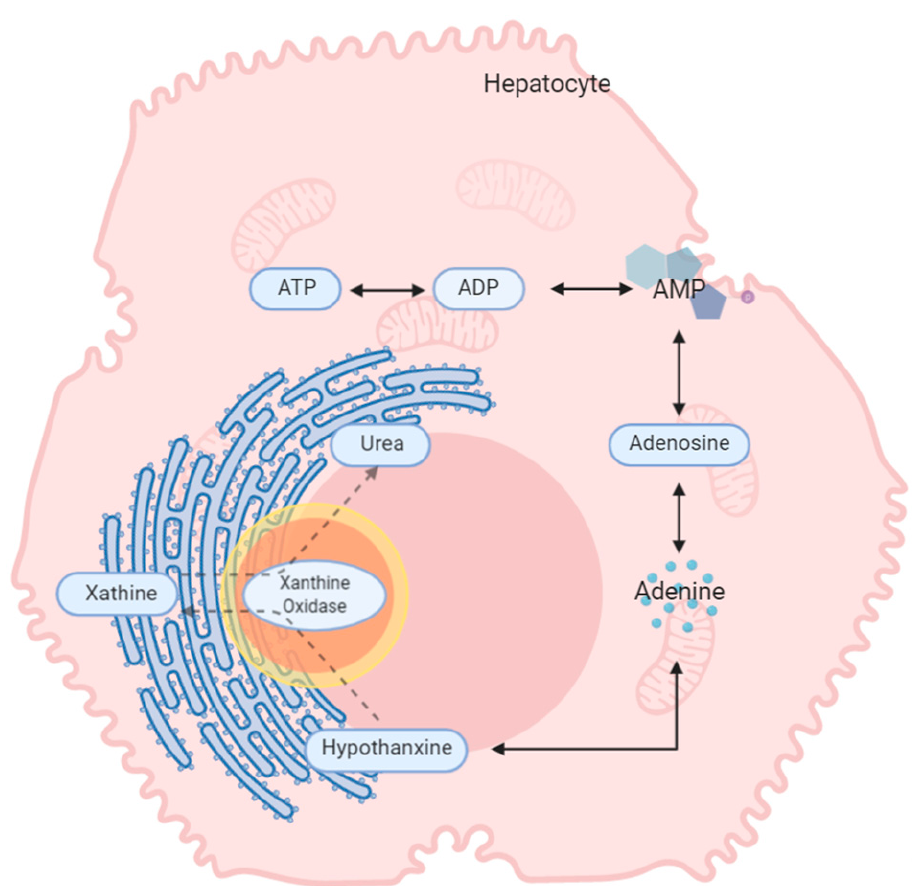
Figure 4. The proposed metabolic changes taking place in explanted liver. During energy production, phosphate groups are sequentially hydrolysed from ATP, creating ADP and then AMP. From AMP, the other metabolites are generated via a number of catabolic pathways. ATP, adenosine triphosphate; ADP, adenosine